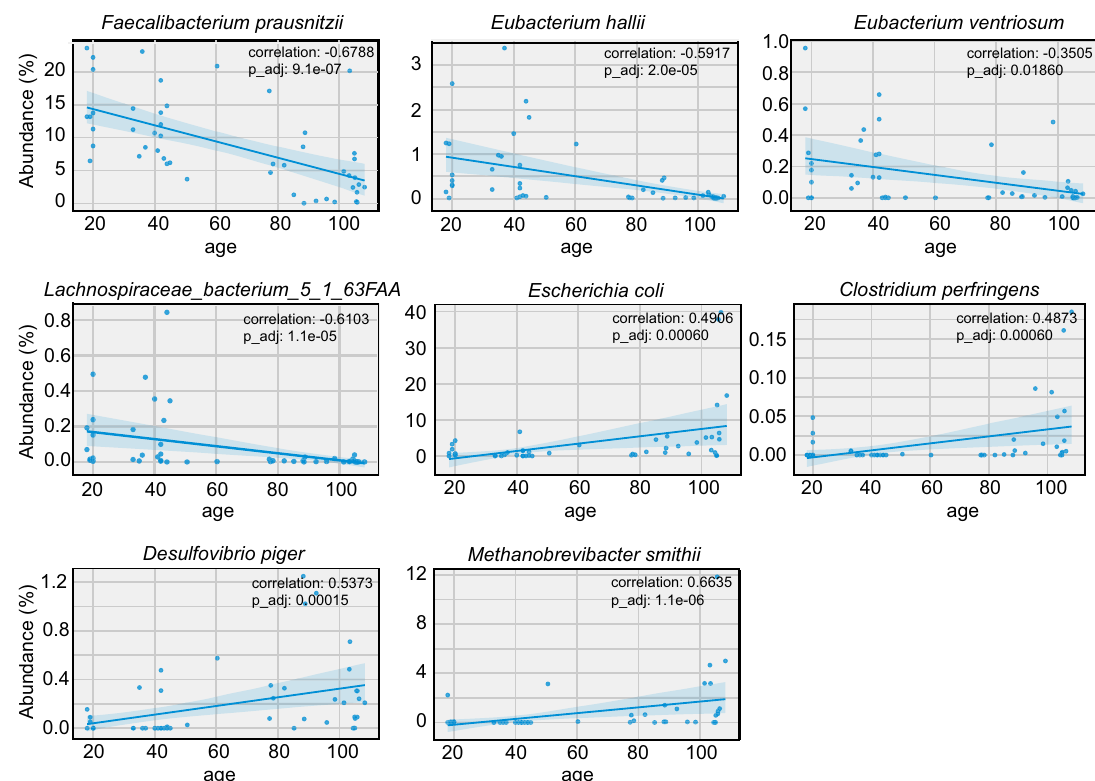
Fig. 5 Regression analysis between the abundance of individual species and the age. Non-parameteric spearman correlation analysis was performed to monitor the correlation of individual species and